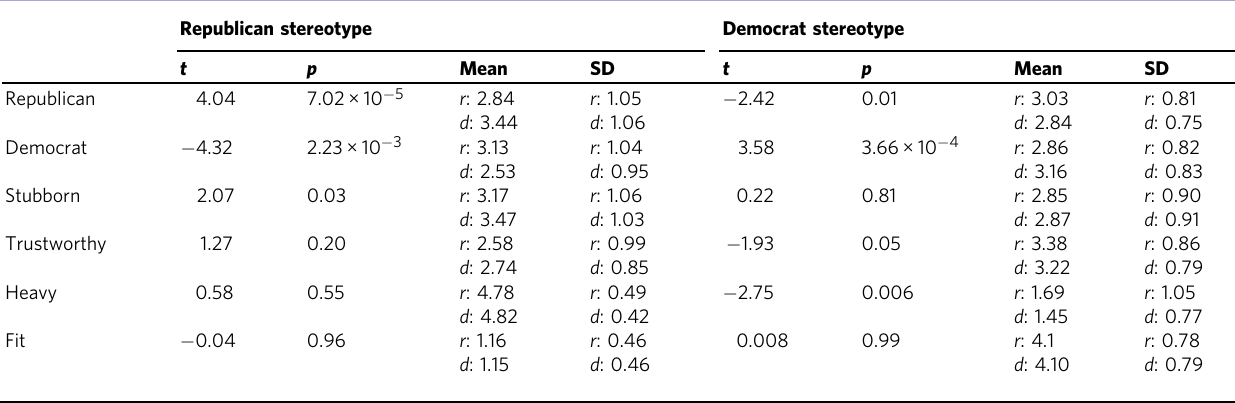
Fig. 5 Mean ratings for the Republican stereotype body (left graph) and the Democrat stereotype body (right graph). The y -axis shows the mean rating value on the 5-point Likert scale ranging from 1: “ strongly disagree ” to 5: “ strongly agree ” . The x -axis shows the trait used to rate the body shape. The red bars show the ratings of the Republican group and the blue bars show the ratings of the Democrat group. Gray bars show the ratings of the Independent group. The bold horizontal line indicates the mean of all ratings collected in Experiment 2. Signi fi cant differences are indicated: *( p < 0.05); **( p < 0.01); ***( p < 0.001) next to the x -axis label for each trait, n.s. indicates no signi fi cant difference. Table 3 Independent t -test for the interaction effect between the Democrat and Republican groups for a speci fi c pair of a trait descriptor and a stereotype